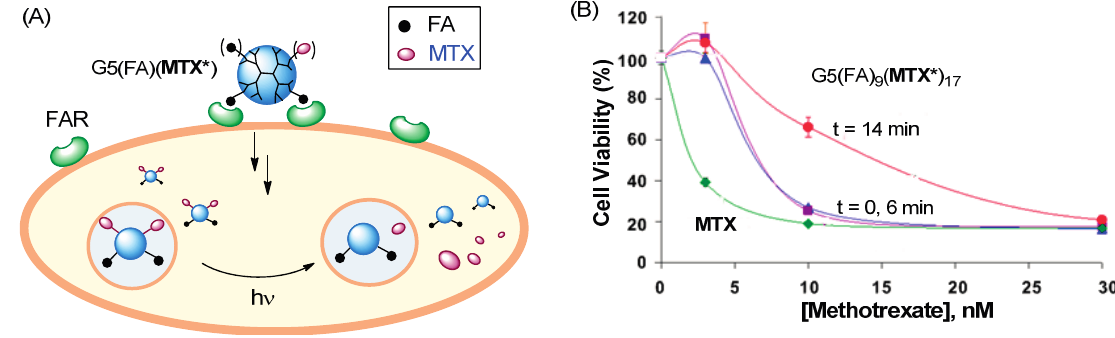
Figure 7. ( A ) Proposed schematic illustrating the concept of light-triggered MTX release; ( B ) In vitro cytotoxicity of G5(FA) 9 (MTX * ) 17 in FAR(+) KB cells, before (control; t = 0) and after UV irradiation ( t = 6 or 14 min) [84]. MTX * = MTX linked with a photocleavable